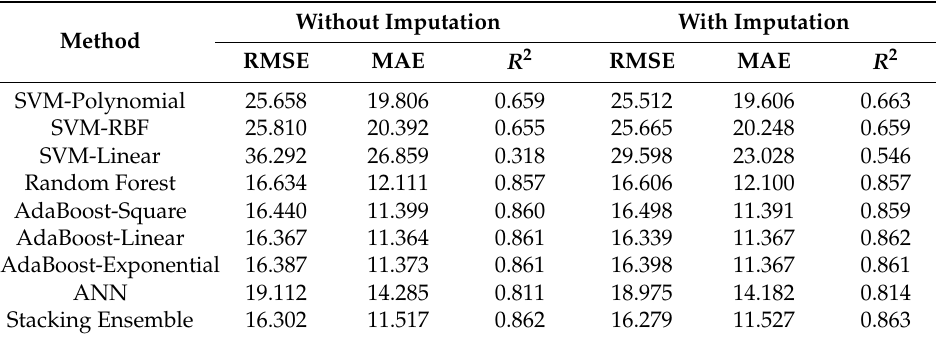
Table 11. Results of ML Algorithms for Fengshan F8-AQI